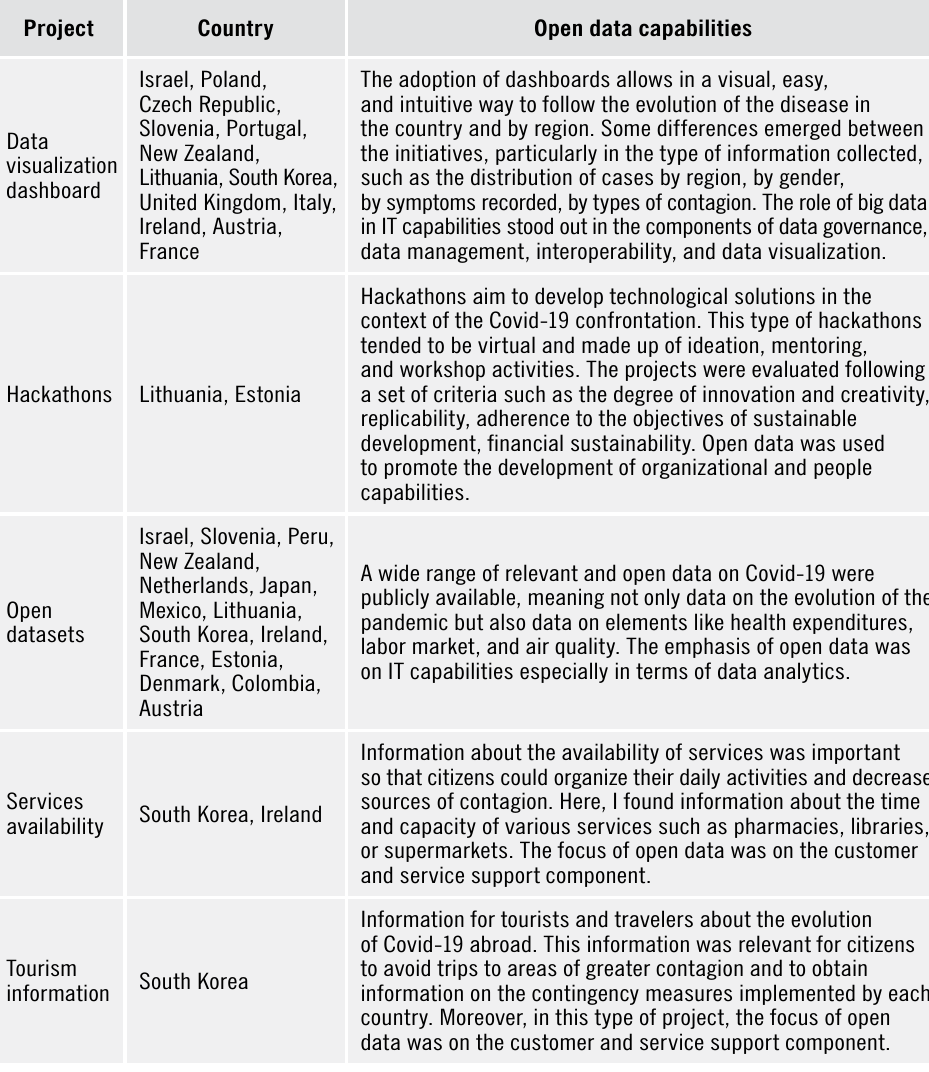
Table 3. Qualitative exploration of innovative